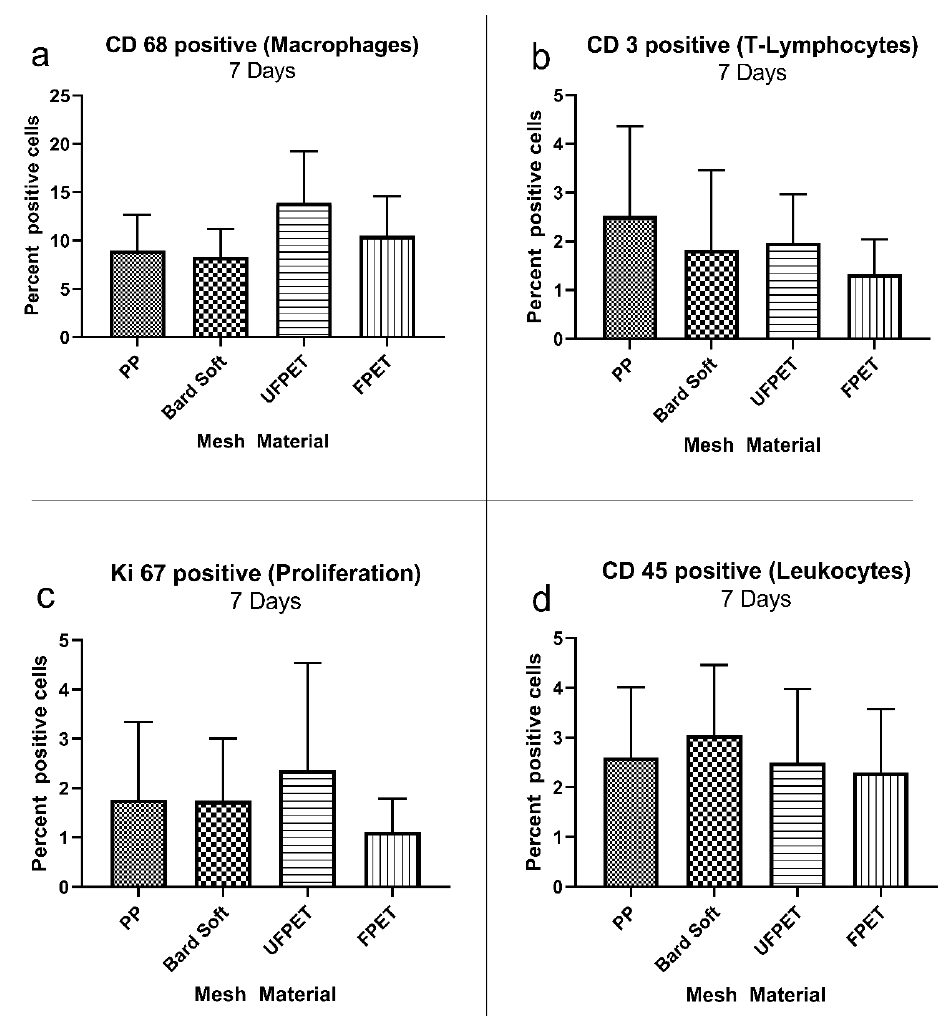
activity. The percentage of positive cells in the respective ROIs did not significantly differ for macrophage (CD 68+), T-cell (CD 3+), lymphocyte (CD 45+), or proliferative activity (KI 67+) after 7 or 21 days. Please refer to Figures 5 and 6 for comparisons and. additionally, to Table 4 for the descriptive statistics.